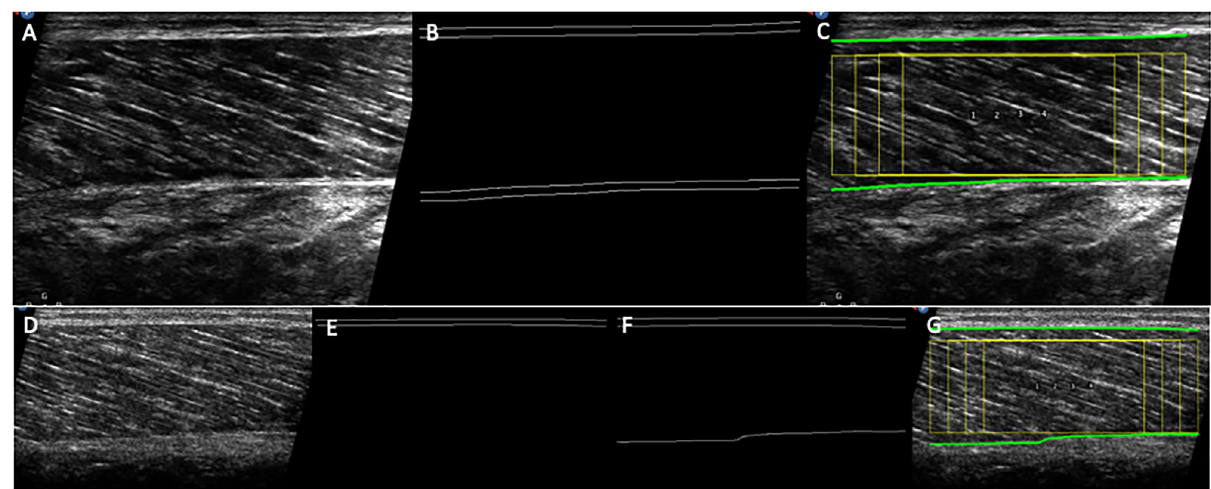
Fig 2. Examples of raw images of the ultrasound field of view, aponeuroses edge detection and overlaid ROIs (yellow) on a suitable scan (A-C), and on a scan where the lower aponeurosis is imaged with insufficient contrast (D-G). In C and G, the paths of the superficial and deep aponeuroses are also indicated as green lines. When the aponeurosis is imaged with insufficient contrast it is not detected (E). In this case using a higher Tubeness sigma may help detection (F-G), although too high values may cause a slight distortion of the aponeurosis edge.